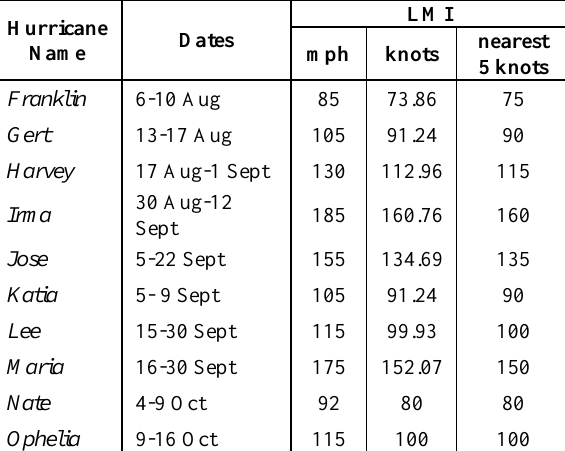
Table 1. The table of Saffir-Simpson hurricane wind scale (SSHWS. From the NHC, https://www.nhc.noaa.gov/ aboutsshws.php. Table